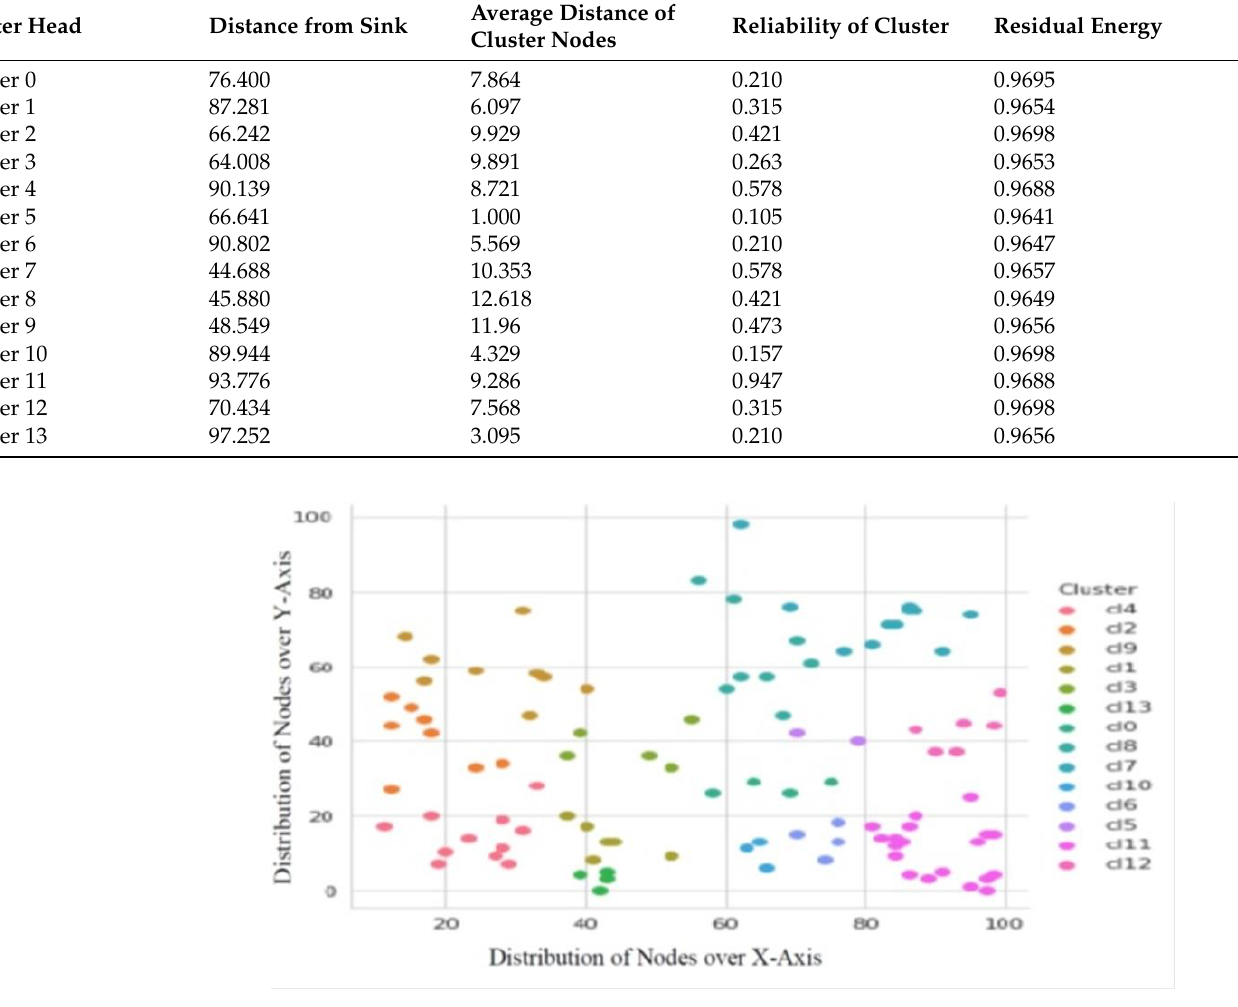
Figure 4. Distribution of 100 nodes into 14 clusters after applying the K-medoids algorithm.